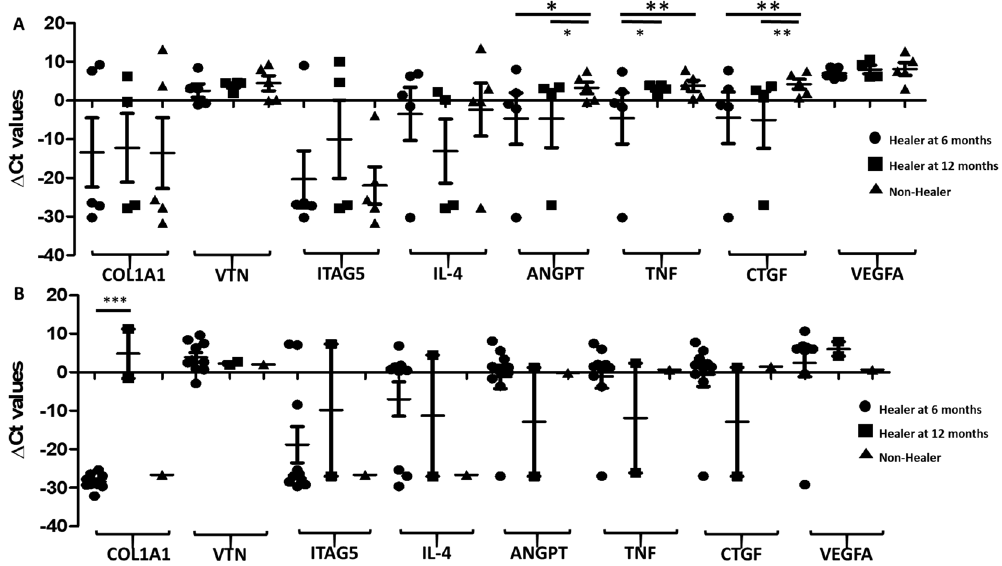
Figure 4. Baseline expression of COL1A1, VTN , ITGA5, IL-4, TNF , ANGPT, VEGFA , and CTGF in ( A ) periapical abscess, and ( B ) periapical periodontitis groups in healing at 6- and 12-months versus non-healing group: The baseline expression of COL1A1, VTN, ITGA5, IL-4, TNF, ANGPT, VEGFA, and CTGF was measured for ( A ) periapical abscess, and ( B ) periapical periodontitis lesions at 6 months (circles), 12 months (squares) and non-healing (triangles) groups. The Y-axis shows the relative expression (ΔCt) of each gene tested, symbols (circles, squares and triangles) represent each data point, and the error bars show the standard error of the mean. The lines with the asterisk sign show a significant difference (*** p < 0.0001, ** p < 0.001, * p < 0.05) in the expression of tested genes between the healing (6–12 months) and non-healing groups.